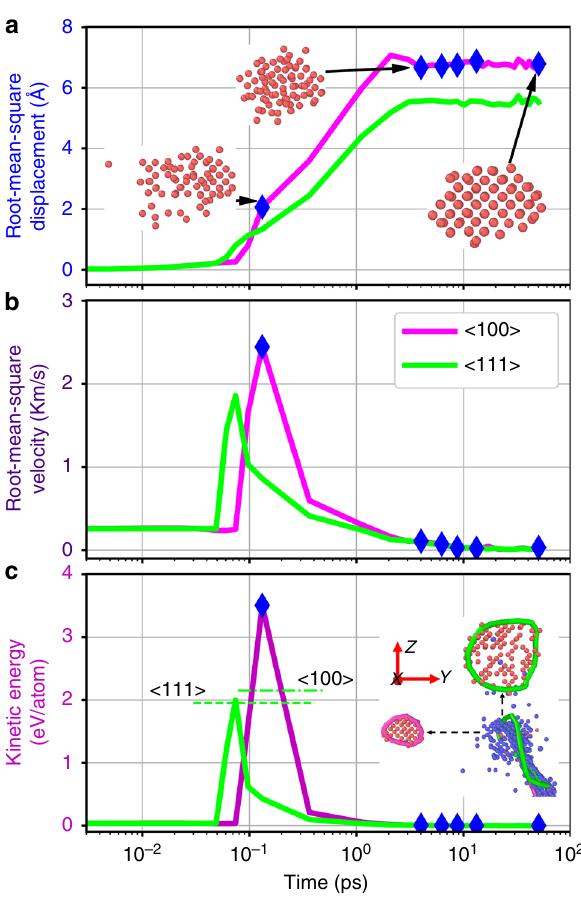
Fig. 2 Punch-out mechanism. One <100> (red) and one <111> (green) interstitial loop are selected for analysis of their a the root-mean-square displacement, b root-mean-square velocity, and c averaged kinetic energy per atom as a function of time for the interstitial atoms forming the dislocation loops. The insets in a show the morphology of the SIA atoms consisting of the <100> loop at three different stages. The blue diamond dots mark the corresponding locations in the curves for the snapshots in Fig. 1. The dash-lines in c mark the formation energies of the dislocation loops per atom. The selected <100> and <111> interstitial loops are in the inset of c with coordination orientation. The red dots denote the interstitial atoms and the blue dots denote the vacancies. The <100> loop and <111> loop are represented by the red and green lines,